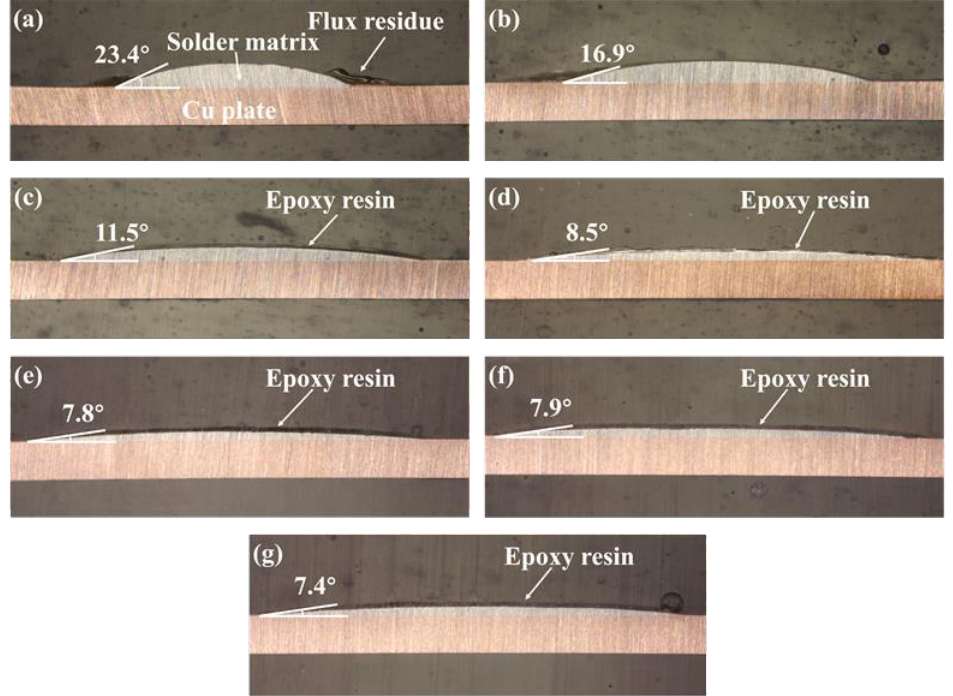
Figure 4. Wetting angles of plain SAC305 and SAC305-xER solder pastes spread on Cu plates: ( a ) plain SAC305, ( b ) x = 2 wt %, ( c ) x = 4 wt %, ( d ) x = 6 wt %, ( e ) x = 8 wt %, ( f ) x = 10 wt %, ( g ) x = 12 wt %.